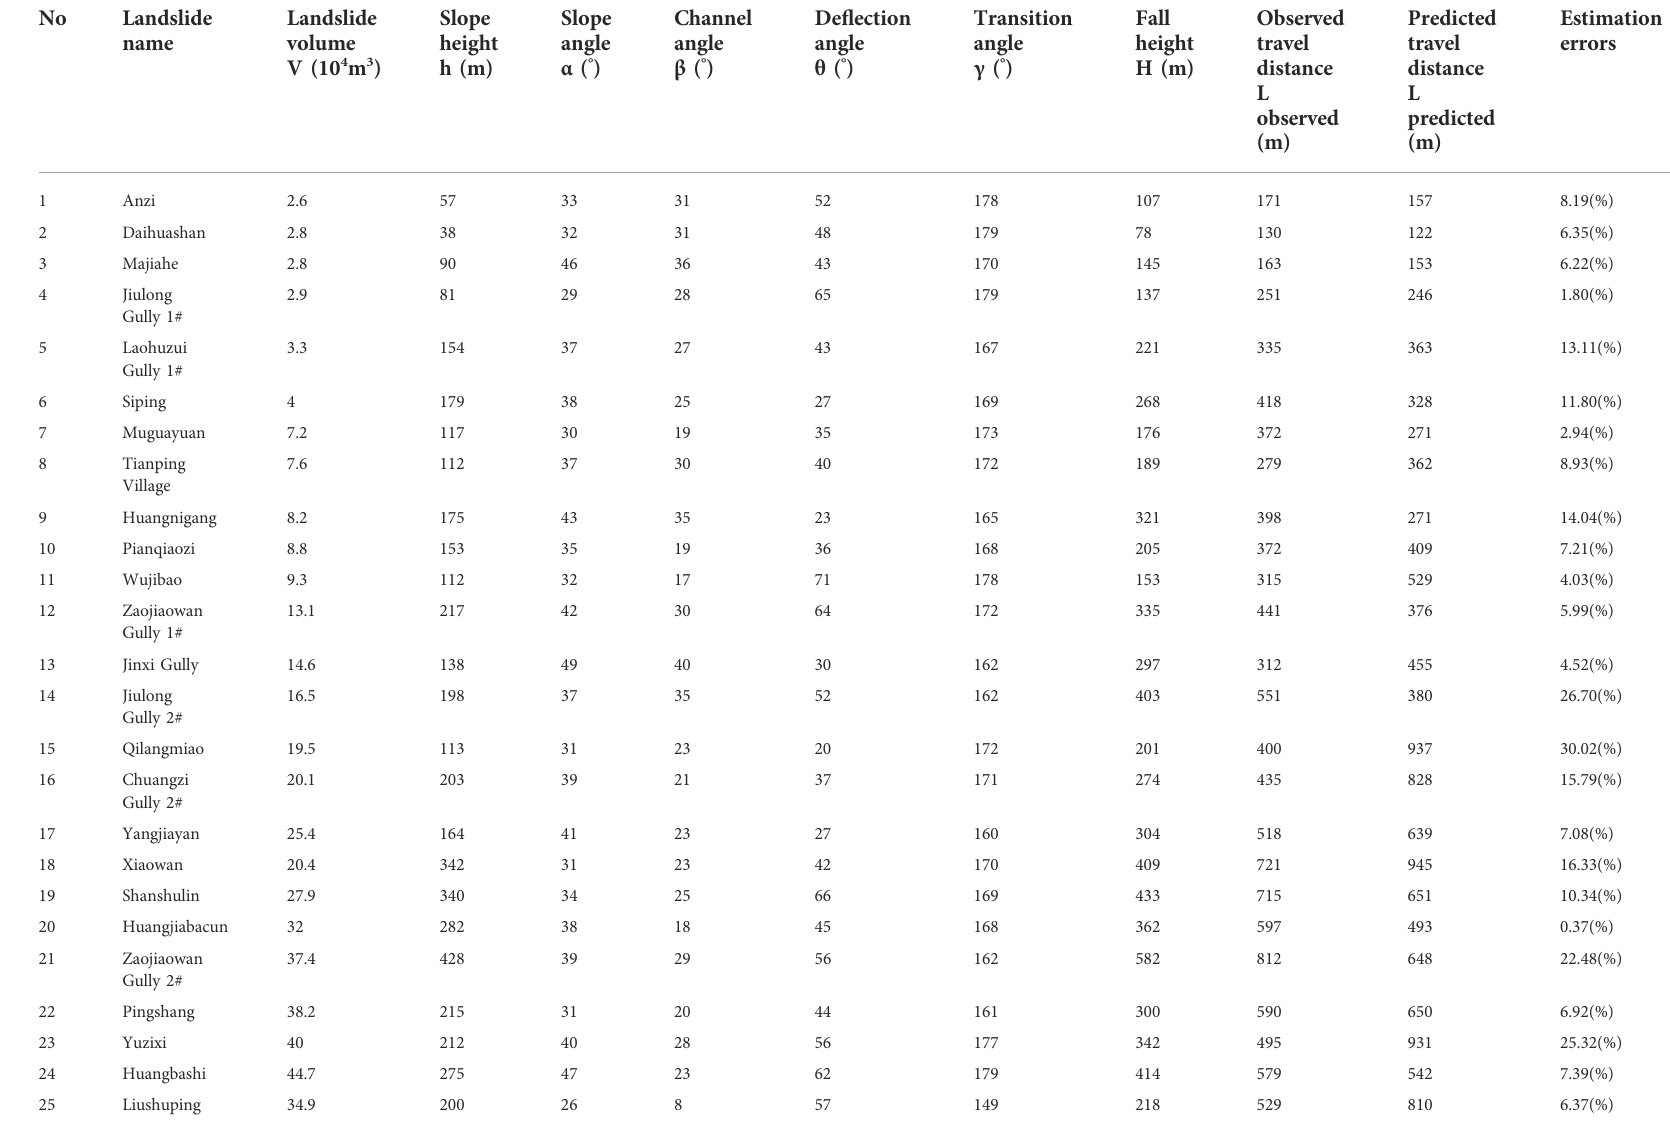
TABLE 2 Data of various parameters of de fl ected-type rock